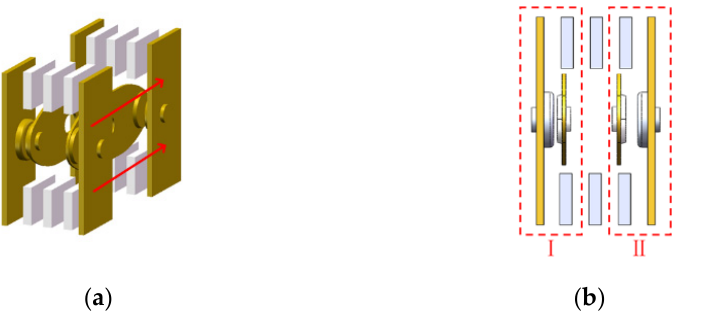
Figure 9. Simulation model of interrupter. ( a ) 3D interrupter model, ( b ) Simulation perspective of interrupter.